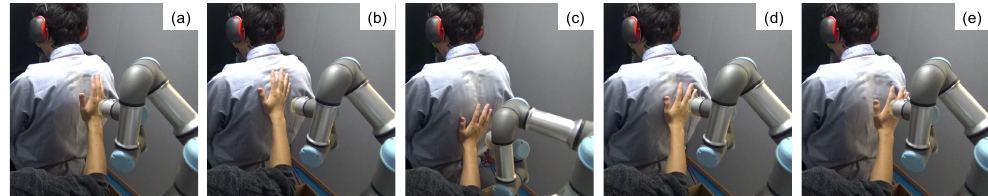
Figure 5. Experimental scene with the human agent. ( a ) Move towards the back. ( b ) Contact the back and keep pressure. ( c , d ) Stroke up and down the back. ( e ) Leave the